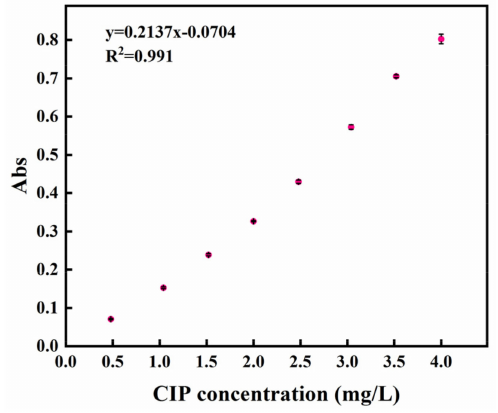
Figure 1. CIP standard working